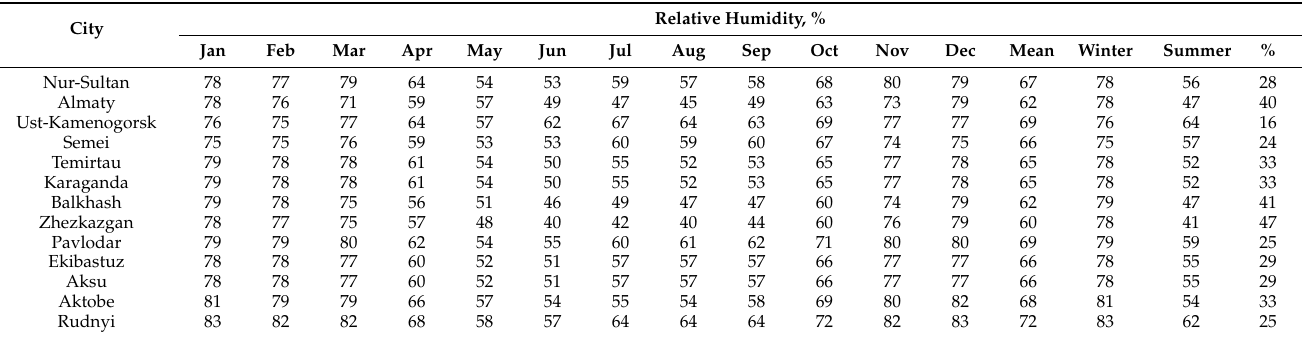
Table A3. Monthly average relative humidity by selected cities (Source: adapted from State standards in the field of architecture, urban planning and construction, 2017 https://igis.kz/images/snip/stroitelnye-normativy/sp-rk-2.04-01-2017-stroitelnaya-klimatologiya. pdf (accessed on 20 February